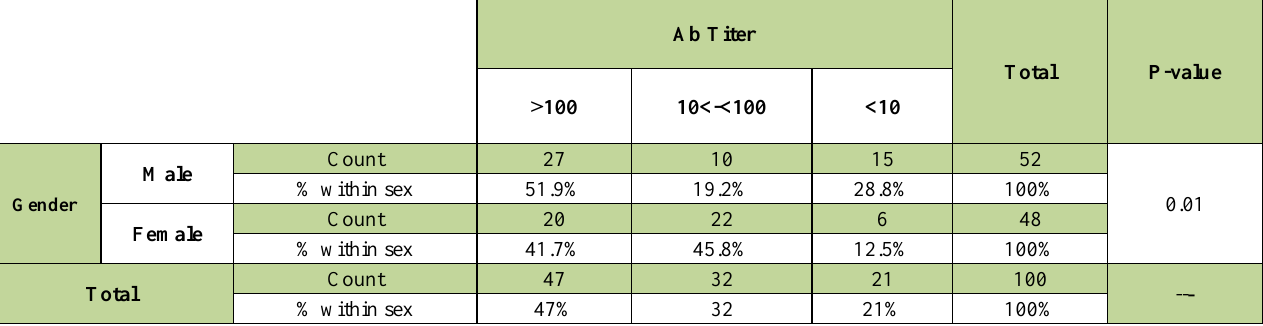
Table 7. Analysis of the relationship between the anti-hepatitis B titration in the samples studied with the gender.